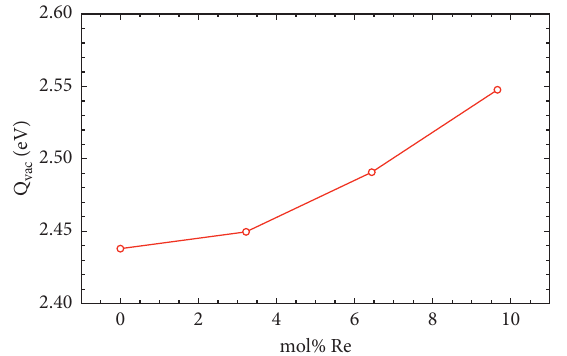
Figure 8: Effective energy barrier Q atomic